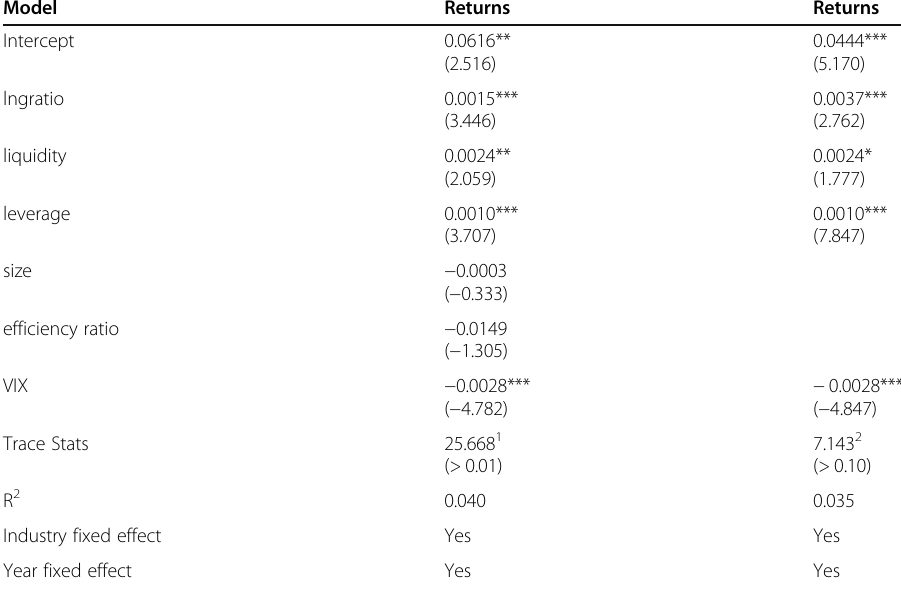
Table 5 Stock return performance of 22 listed shipping firms that extended into LNG carrier